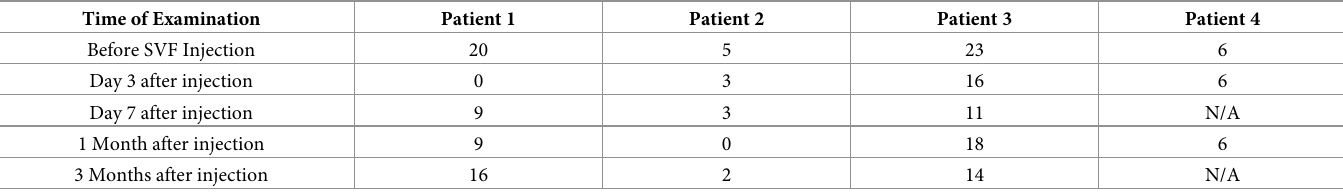
Table 3. PainDETECT questionnaire scores for each patients. Time of